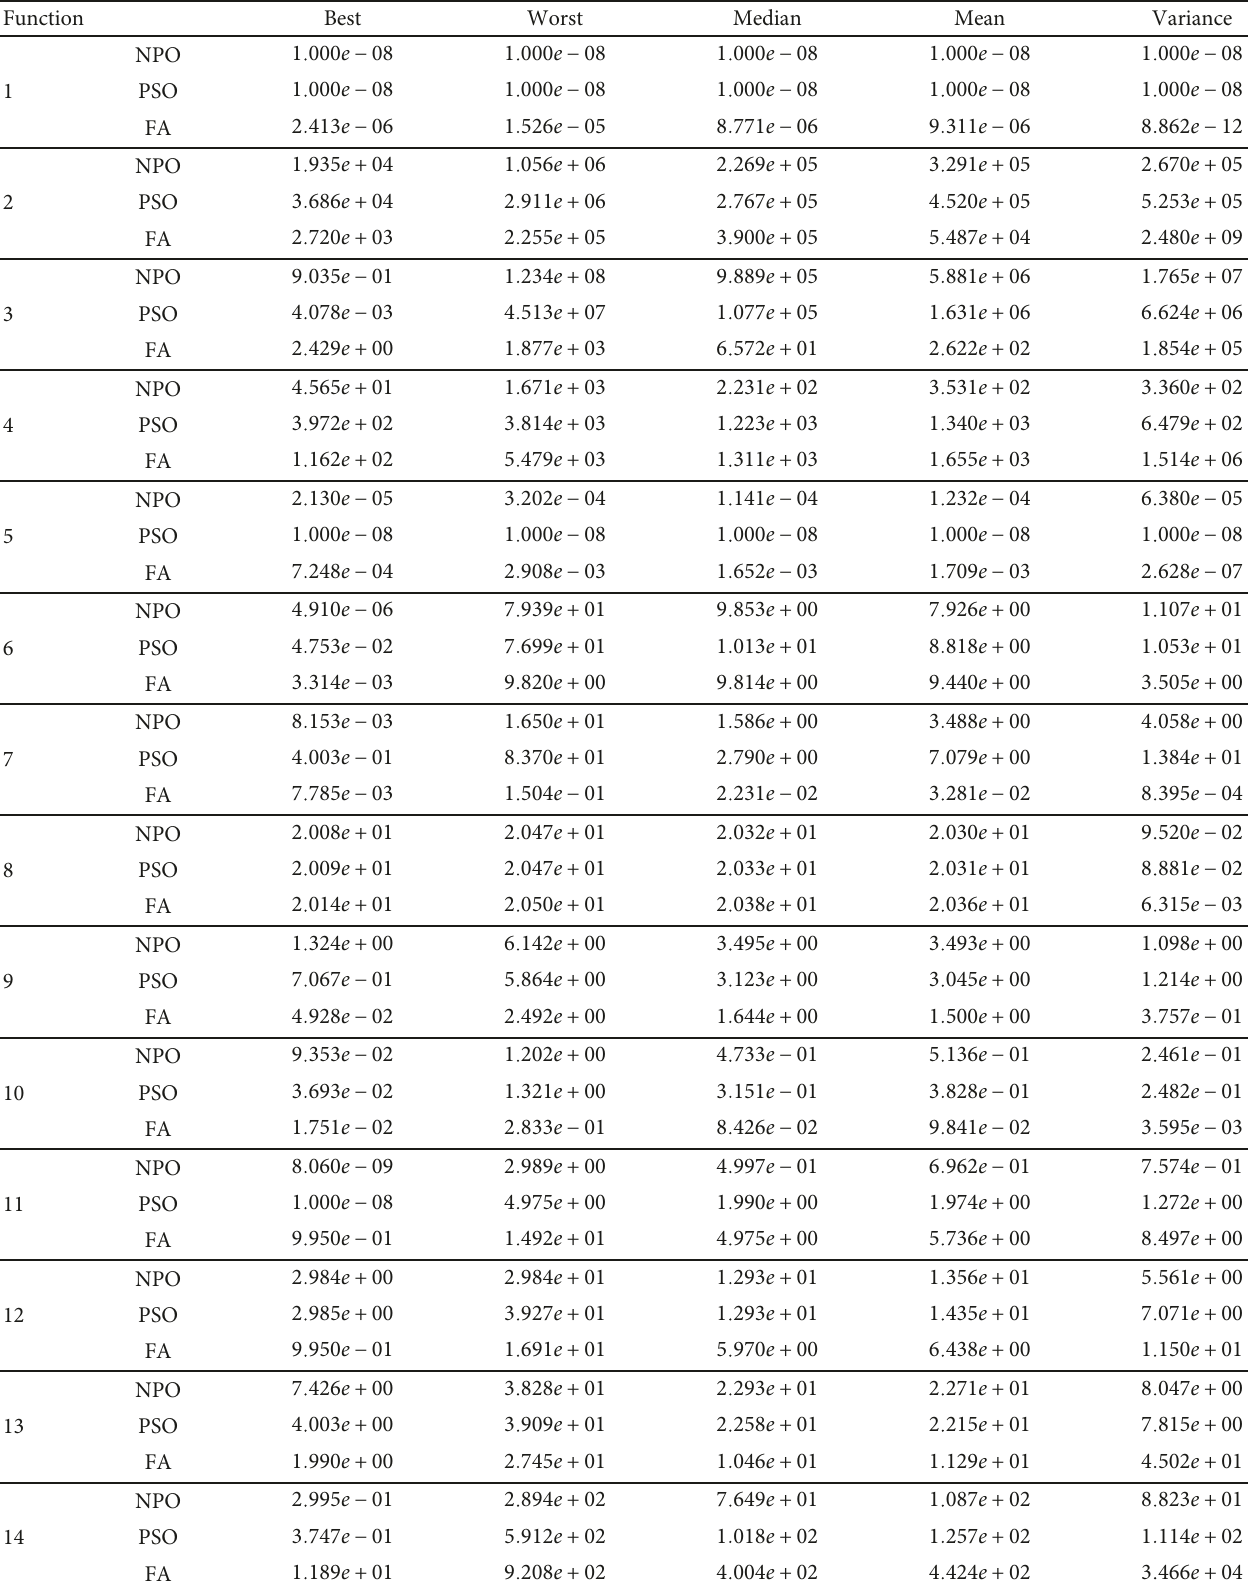
Table 1: Benchmark for NPO, PSO, and FA: tested with 28 10-dimensional functions from CEC 2013 competition.